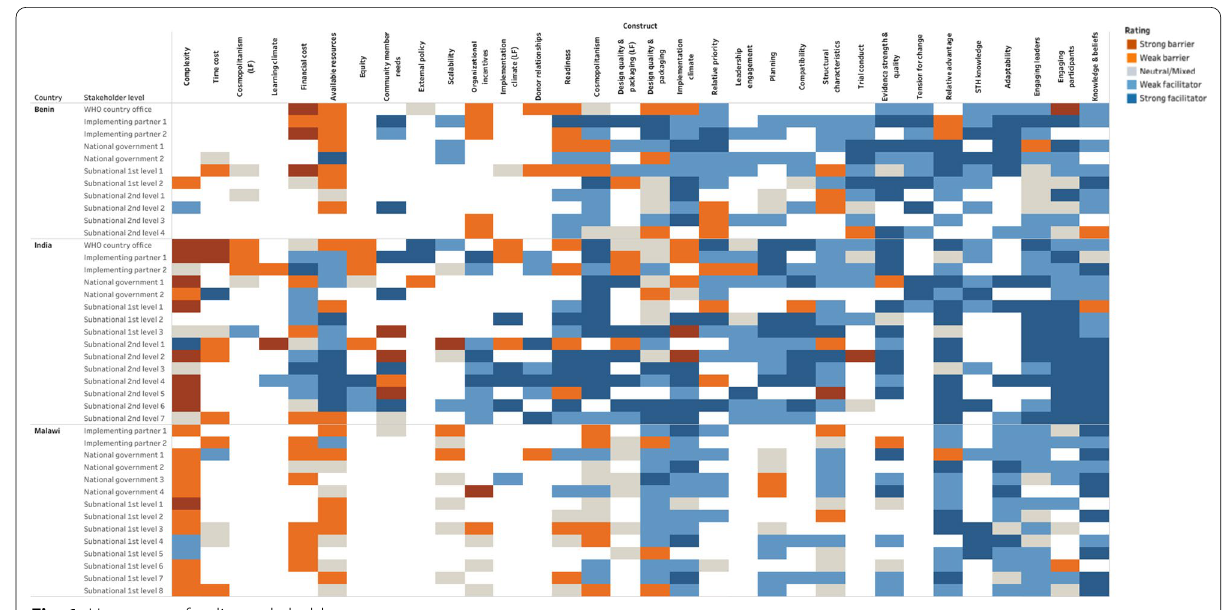
Fig. 1 Heatmaps of policy